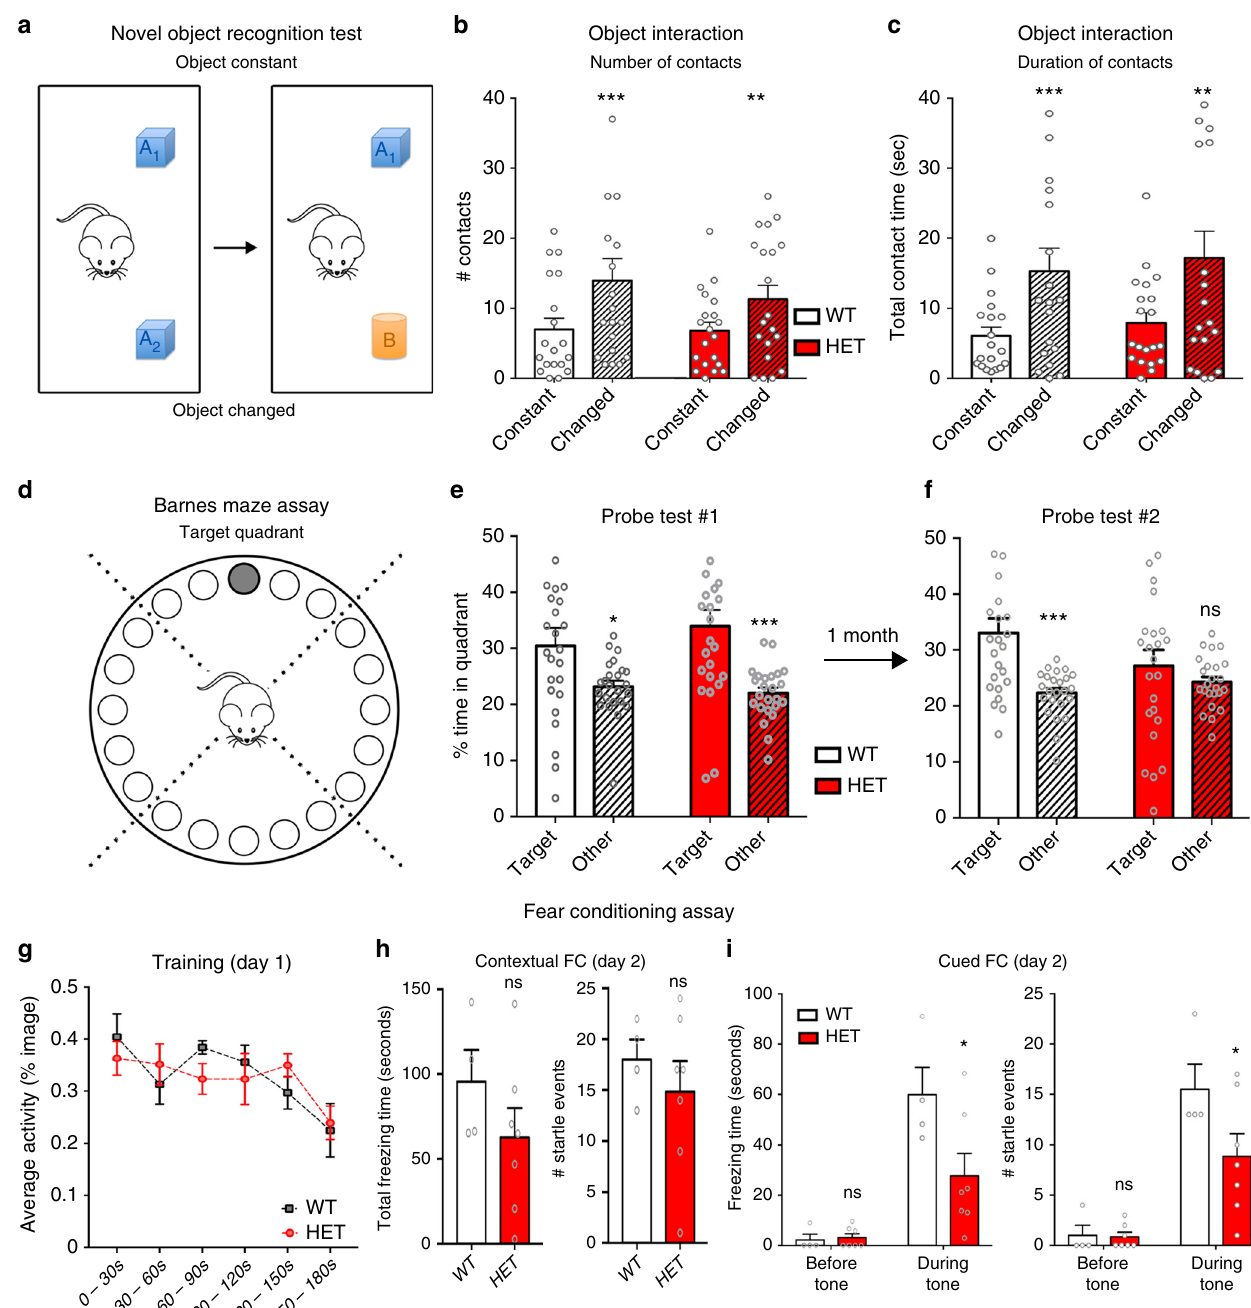
Fig. 3 Long-term memory consolidation phenotype of NUAK1 HET mice. a Novel object assay design. Mice were exposed to two similar objects, followed by a change in one of the two objects. b , c Quanti fi cation of the number ( b ) and duration ( c ) of contacts during the novel object recognition assay. Average ± SEM. N WT = 19, N HET = 20. Analysis: 2-way ANOVA with Bonferroni ’ s multiple comparisons. ** p < 0.01, *** p < 0.001. d Barnes Maze spatial memory assay. e Quanti fi cation of time spent in target quadrant versus in other quadrants. f Mice were tested after 1 month to assess memory consolidation. Average± SEM. Analysis: 2-way ANOVA with Bonferroni ’ s multiple comparisons. ns: p > 0.05, * p < 0.05, *** p < 0.001. g , i Fear conditioning assay. g On day 1, mice were placed in the apparatus for 3 min. After a 2 min period, a 30 s tone was produced, and paired with a single electric shock. Spontaneous activity was recorded over 30 s bins. h – i on day 2, mice were tested for startle response (total duration and number of events) upon exposition to the same environment (contextual memory) and upon exposure to the tone in a modi fi ed environment (cued memory). Average ± SEM. N WT = 4, N HET = 7. Analysis: Mann – Whitney ( h ) or 2-way ANOVA with Bonferroni ’ s multiple comparisons ( i ). ns: p > 0.05, * p <